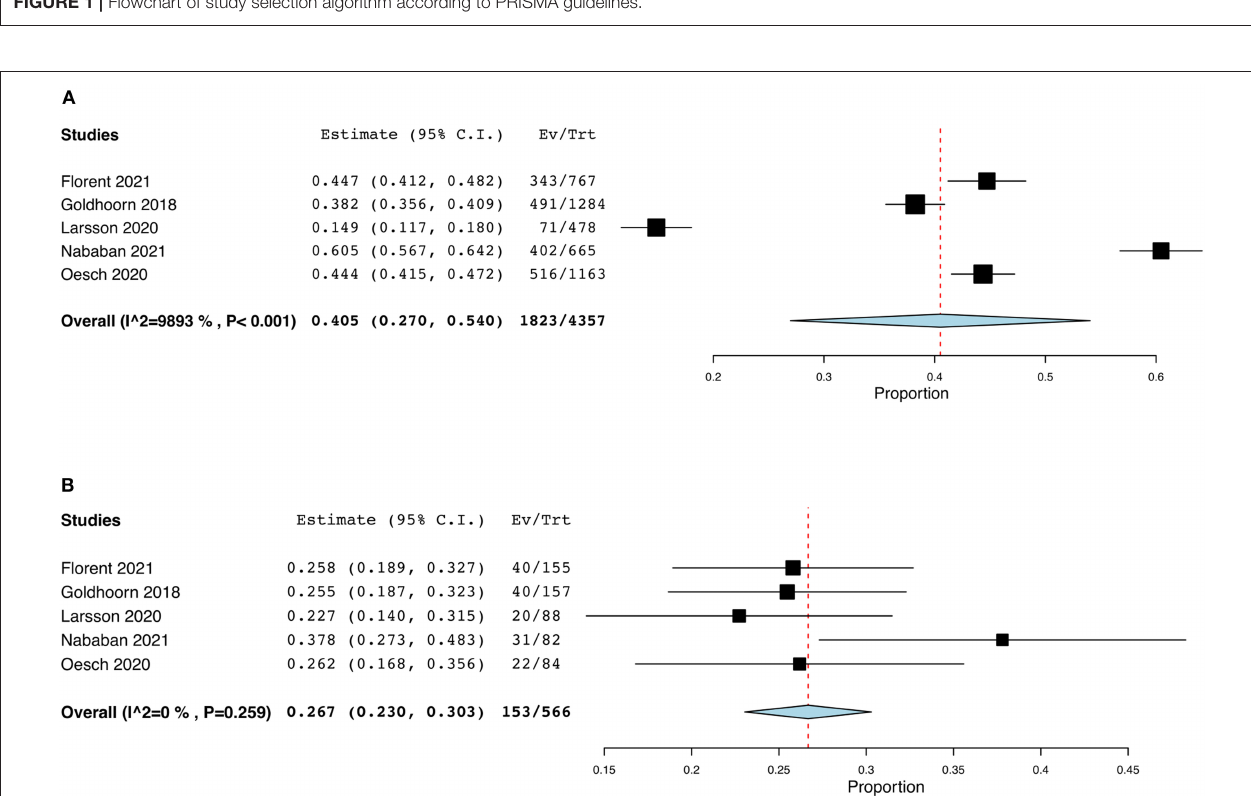
FIGURE 2 | Forest plots: (A) proportional meta-analysis of the percentage of patients with good clinical outcome in the non-PSD group, (B) proportional meta-analysis of patients with good clinical outcome in the PSD group.